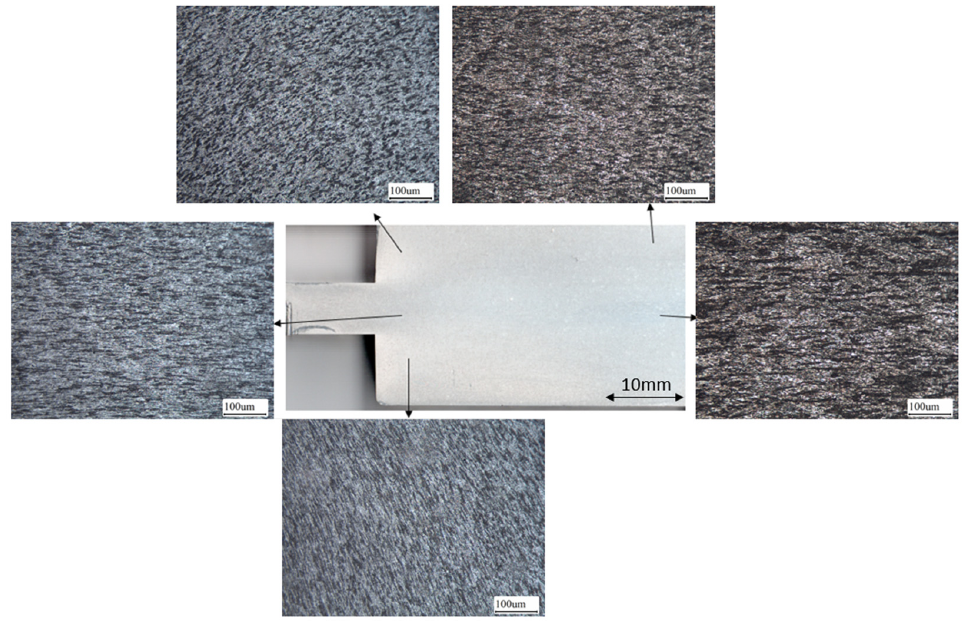
Figure 3. The macrostructures of the as-forged HF62 samples, showing the distribution of flow lines and deformation bands.